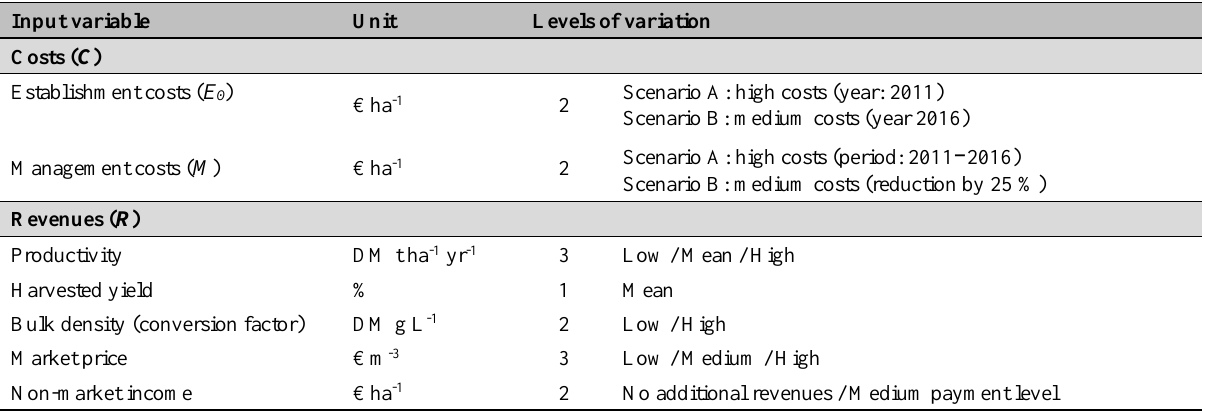
Table 1. Overview of sensitivity analysis varying input variables for profitability assessment and break-even price calculation. Abbreviations for variables as in the equations, DM = dry